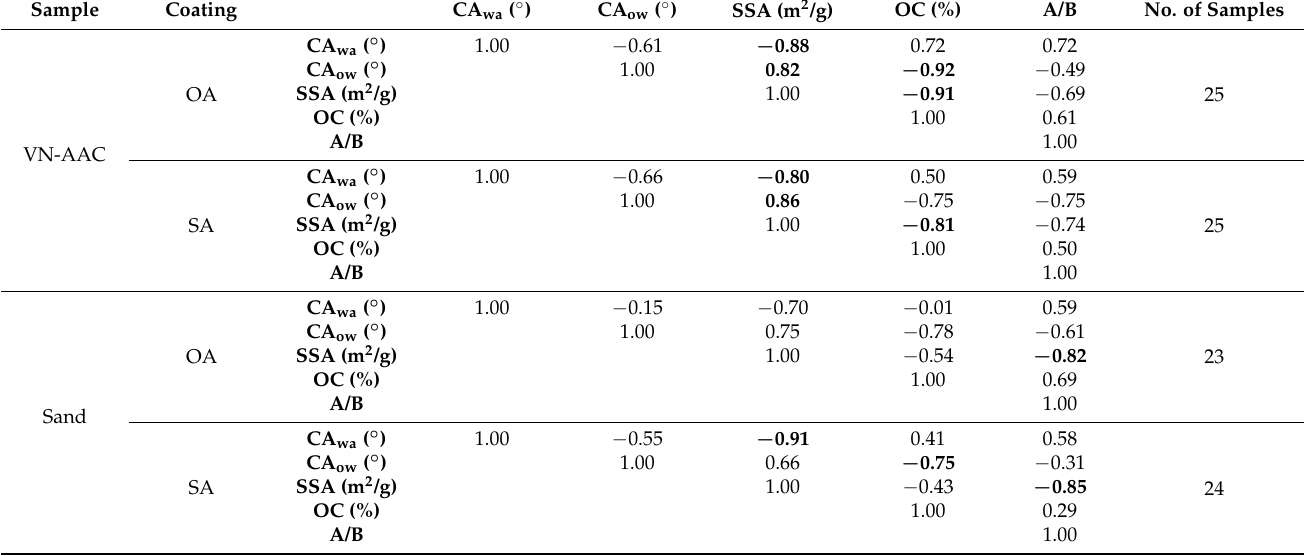
Table 3. Pearson correlation matrix of measured parameters for VN-AAC grains and sands tested in this study. Values > |0.80| are given in